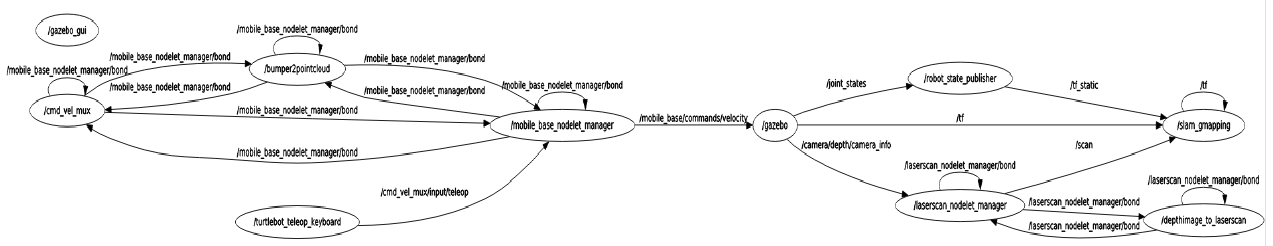
Fig. 5: Rqt graph gmapping